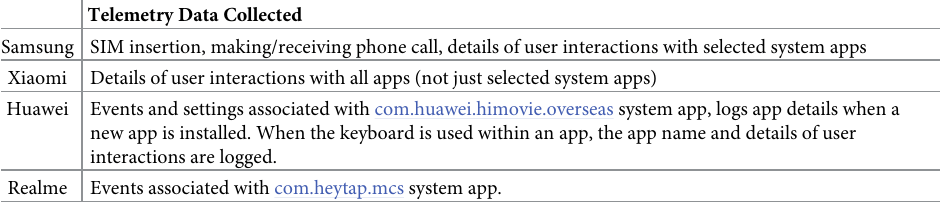
Table 6. Summary of telemetry data sent in network connections. Telemetry Data